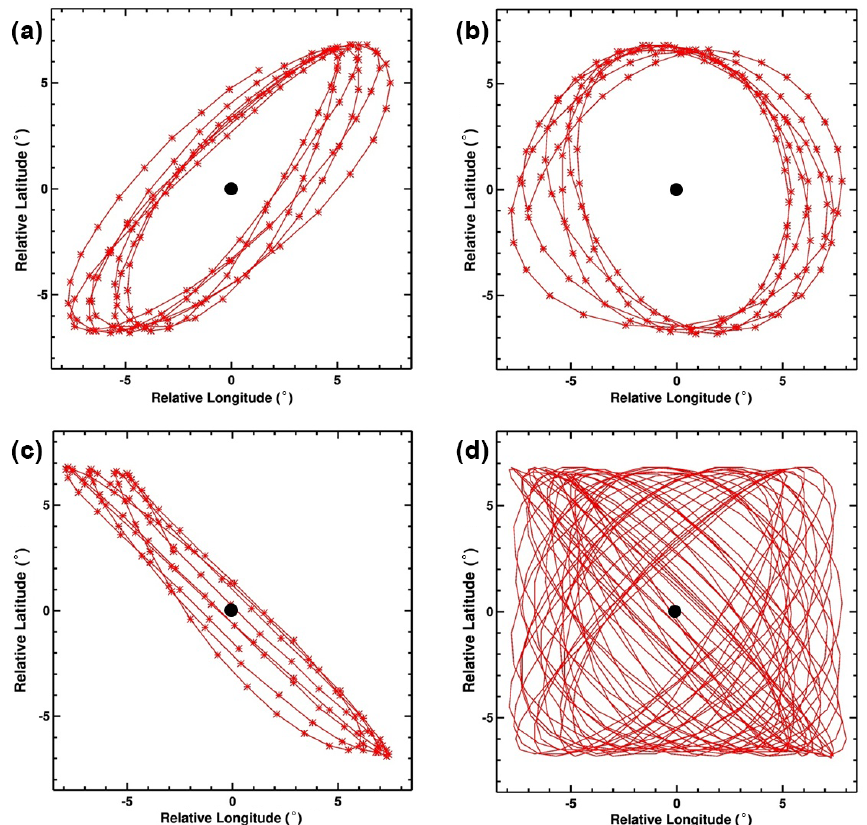
Figure 7. Visual librations of Earth in the Moon’s sky during (a) the first 6 months 2022, (b) the first 6 months 2023, (c) July–October 2024, and (d) 2022–2024 (the dots are deleted). The latitude and longitude of the libration of the Moon (Giesen, 2018; Espenak, 2021) were converted to the relative Earth libration angles using a sign change. The positions of the Earth in the sky of the Moon are plotted in increments of a day. If there were no lunar libration, then the Earth would be at the black dot in the center of the